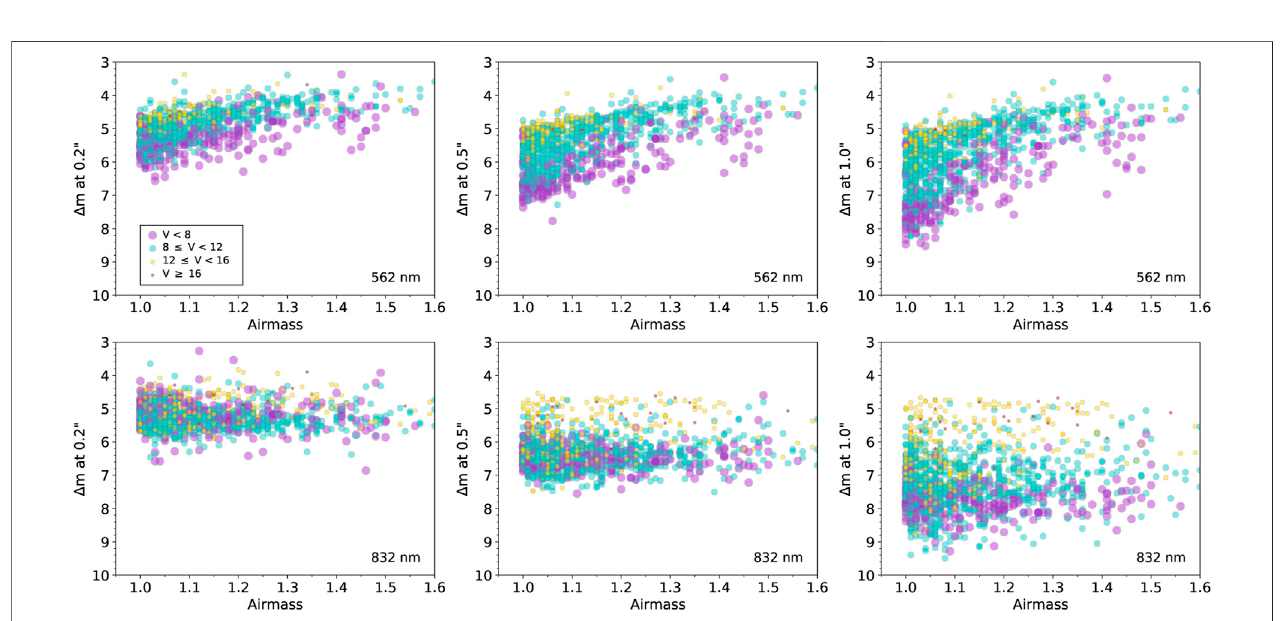
FIGURE 6 | Similar to Figure 5 , but showing the results from Zorro